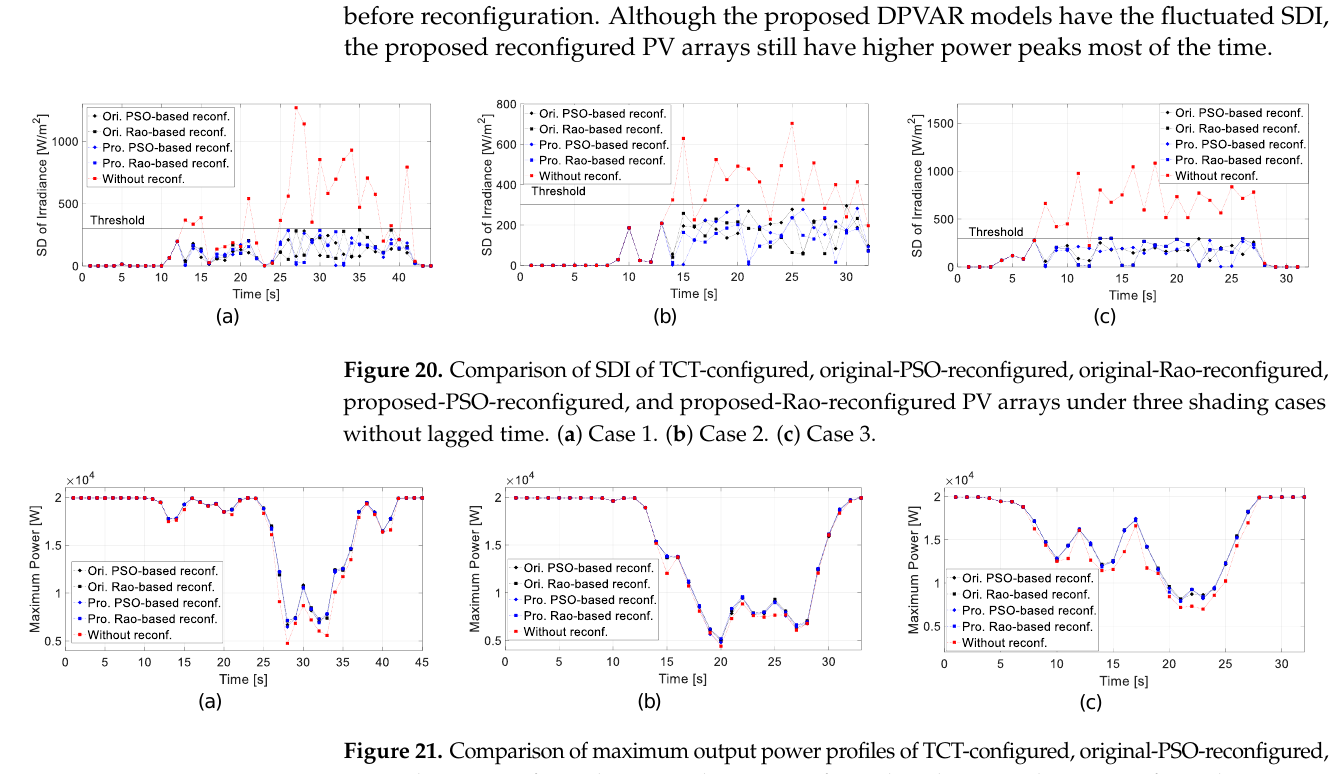
Table 3. Summary performance metrics of PV array under PSC without considering time lagging